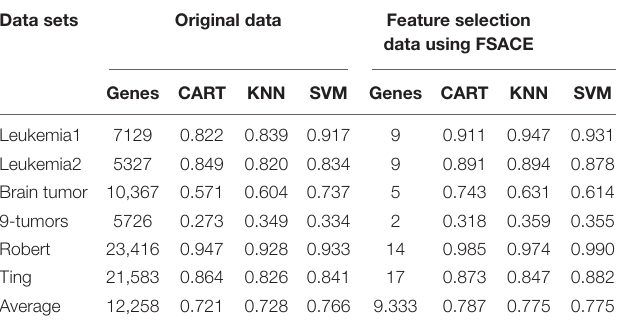
TABLE 6 | Classification accuracy of Brain tumor using six different feature selection algorithms.